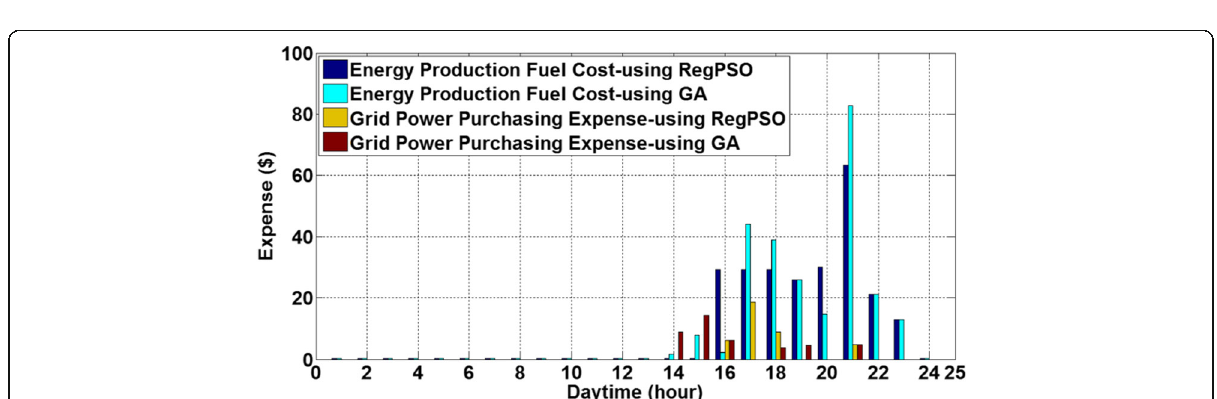
Fig. 17 Hourly comparison of energy production fuel costs and grid power purchasing expenses in non-isolated mode of operation